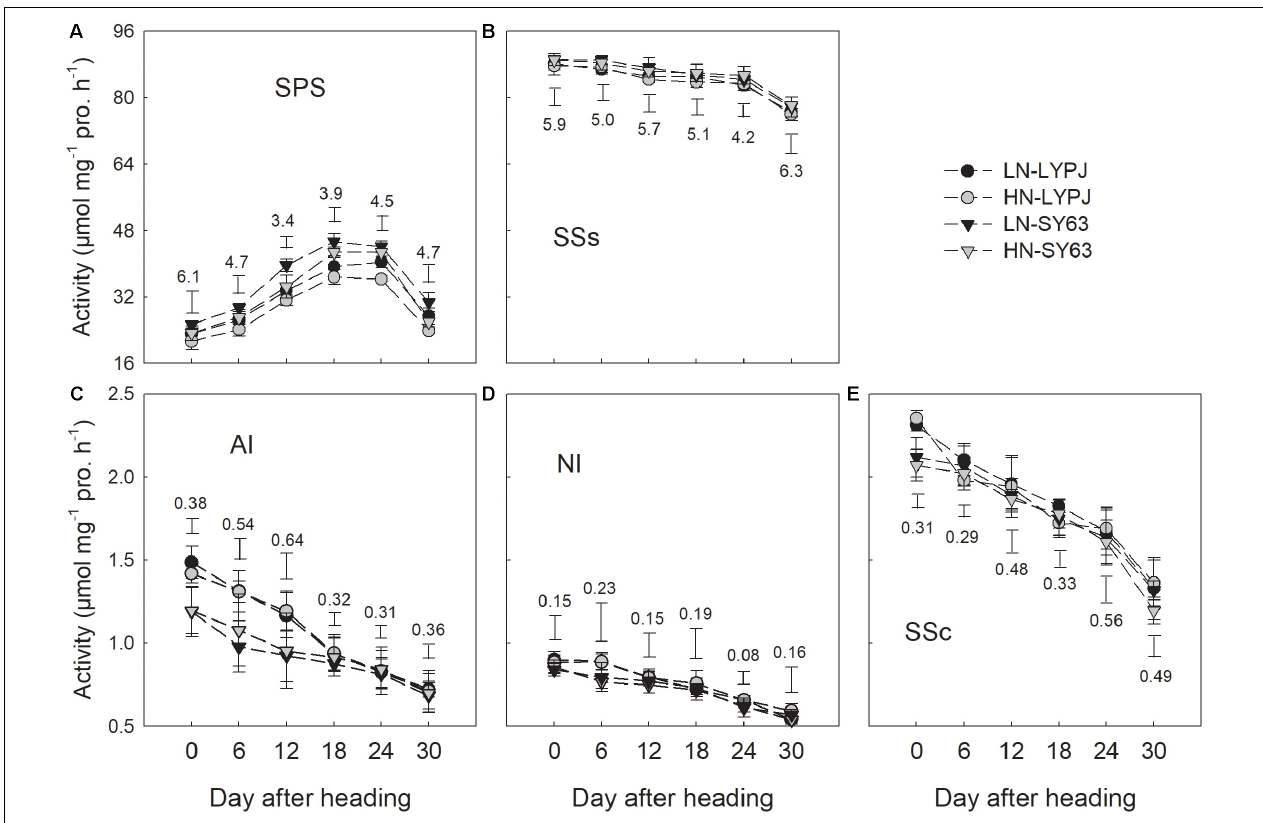
FIGURE 7 | Activities of SPS (A) , SSs (B) , AI (C) , NI (D) , and SSc (E) in the stems of LYPJ and SY63 cultivars under LN and HN treatments. Data are shown as mean ± standard error ( n = 3). Vertical bar with number represents LSD 0 . 05 for difference significance of mean among 4 combinations at an identical time